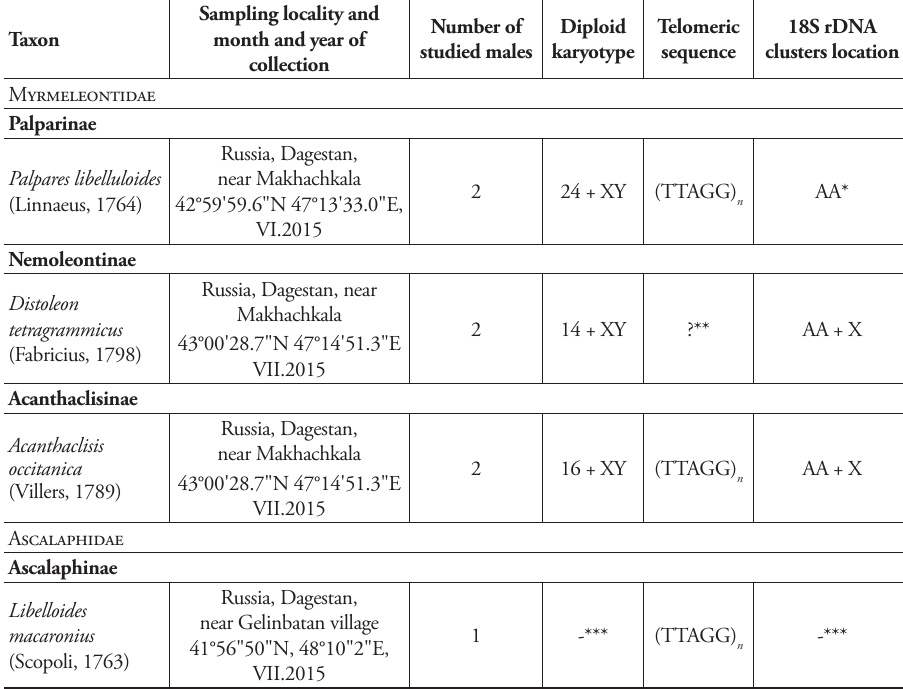
Number of Diploid Telomeric 18S rDNA studied males karyotype sequence clusters